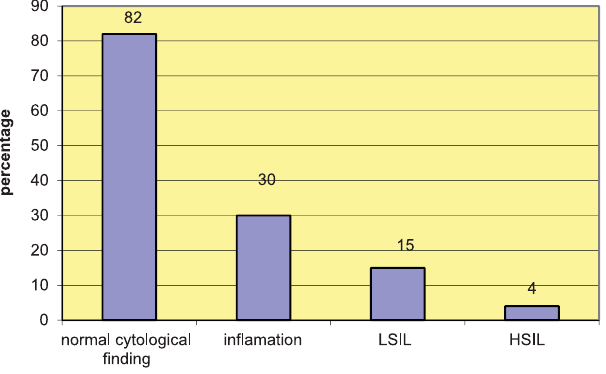
FIGURE 8. Citological fi ndings. Normal colposcopic image. When the colposcopic image was regular, there were mostly normal colposcopic images, and cytological and pathological fi ndings were mostly related to in fl ammation, to a lesser extent LSIL and